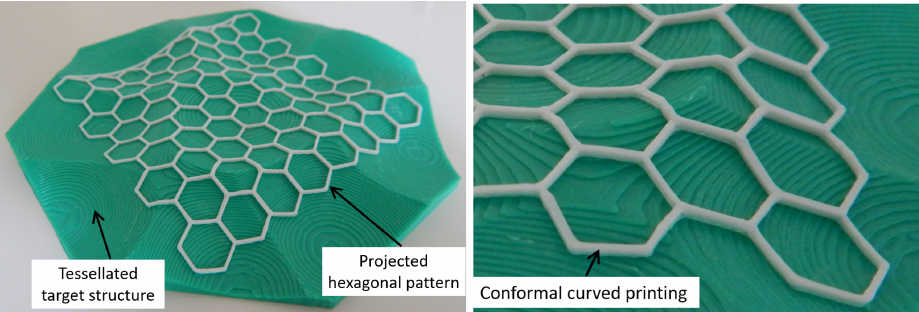
Figure 18. Actual 3D printing of hexagonal pattern projected on an arbitrary tessellated tar- get